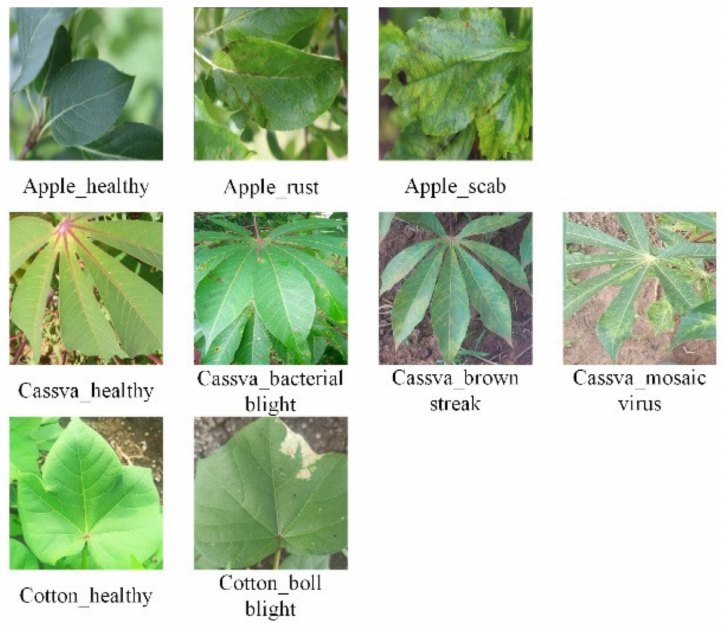
Figure 2. Leaf disease images in natural